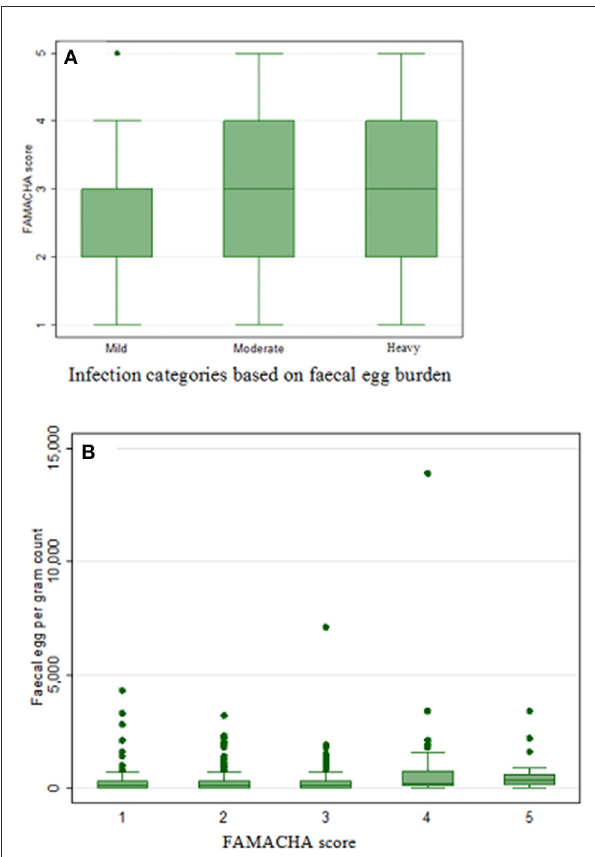
FIGURE1 Box plot demonstrating the relationship between: (A) FAMACHA score and infection category, and (B) fecal egg count and FAMACHA score in sheep.